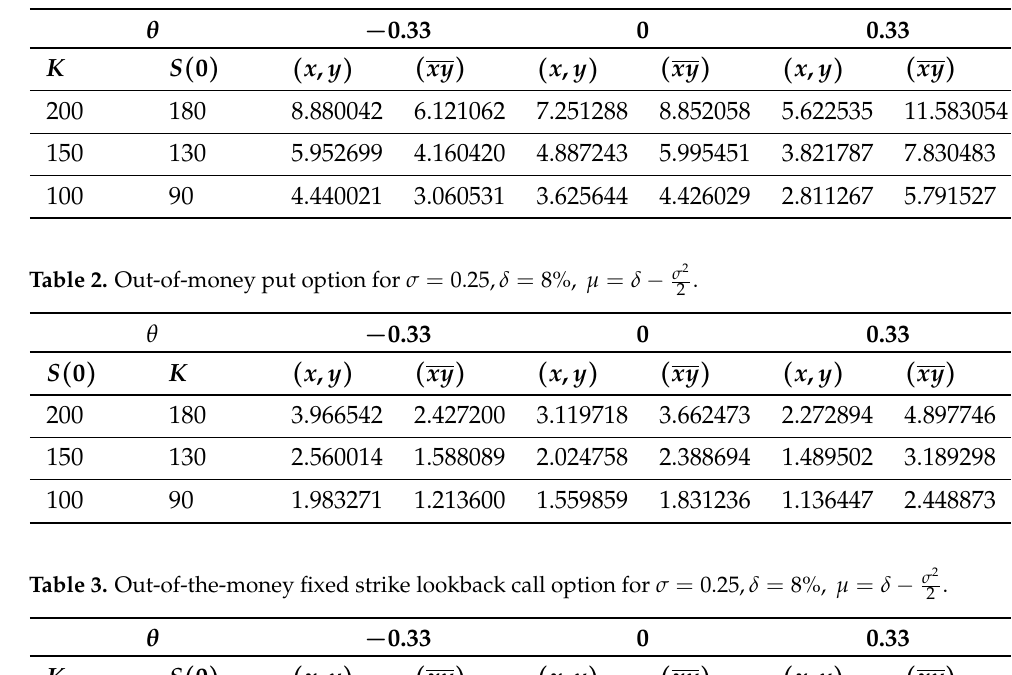
Table 1. Out-of-money call option for σ = 0.25, δ = 8%, µ = δ − σ 2